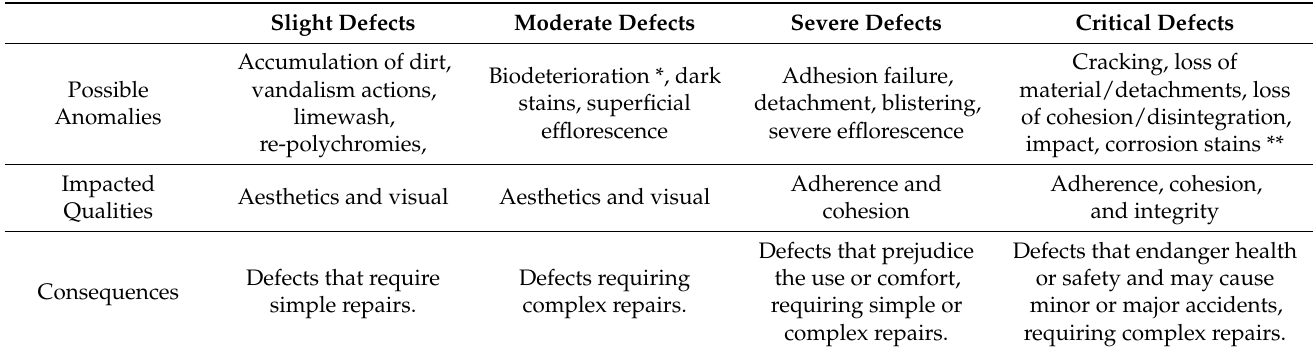
Table 1. Rules for assessing the severity of